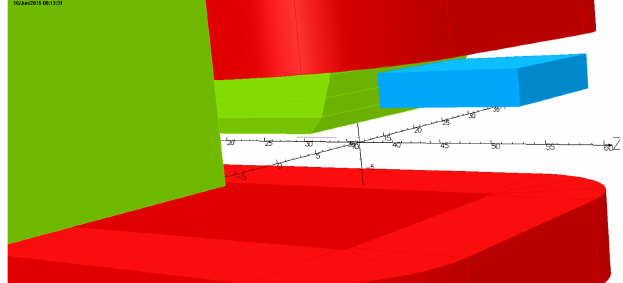
FIG. 3. Example of a Class-R field-extension design: a single rectangular plate 10 cm by 11 cm. The magnet yoke and main pole piece are shown in green, the coils in red, and the field extension component in blue.